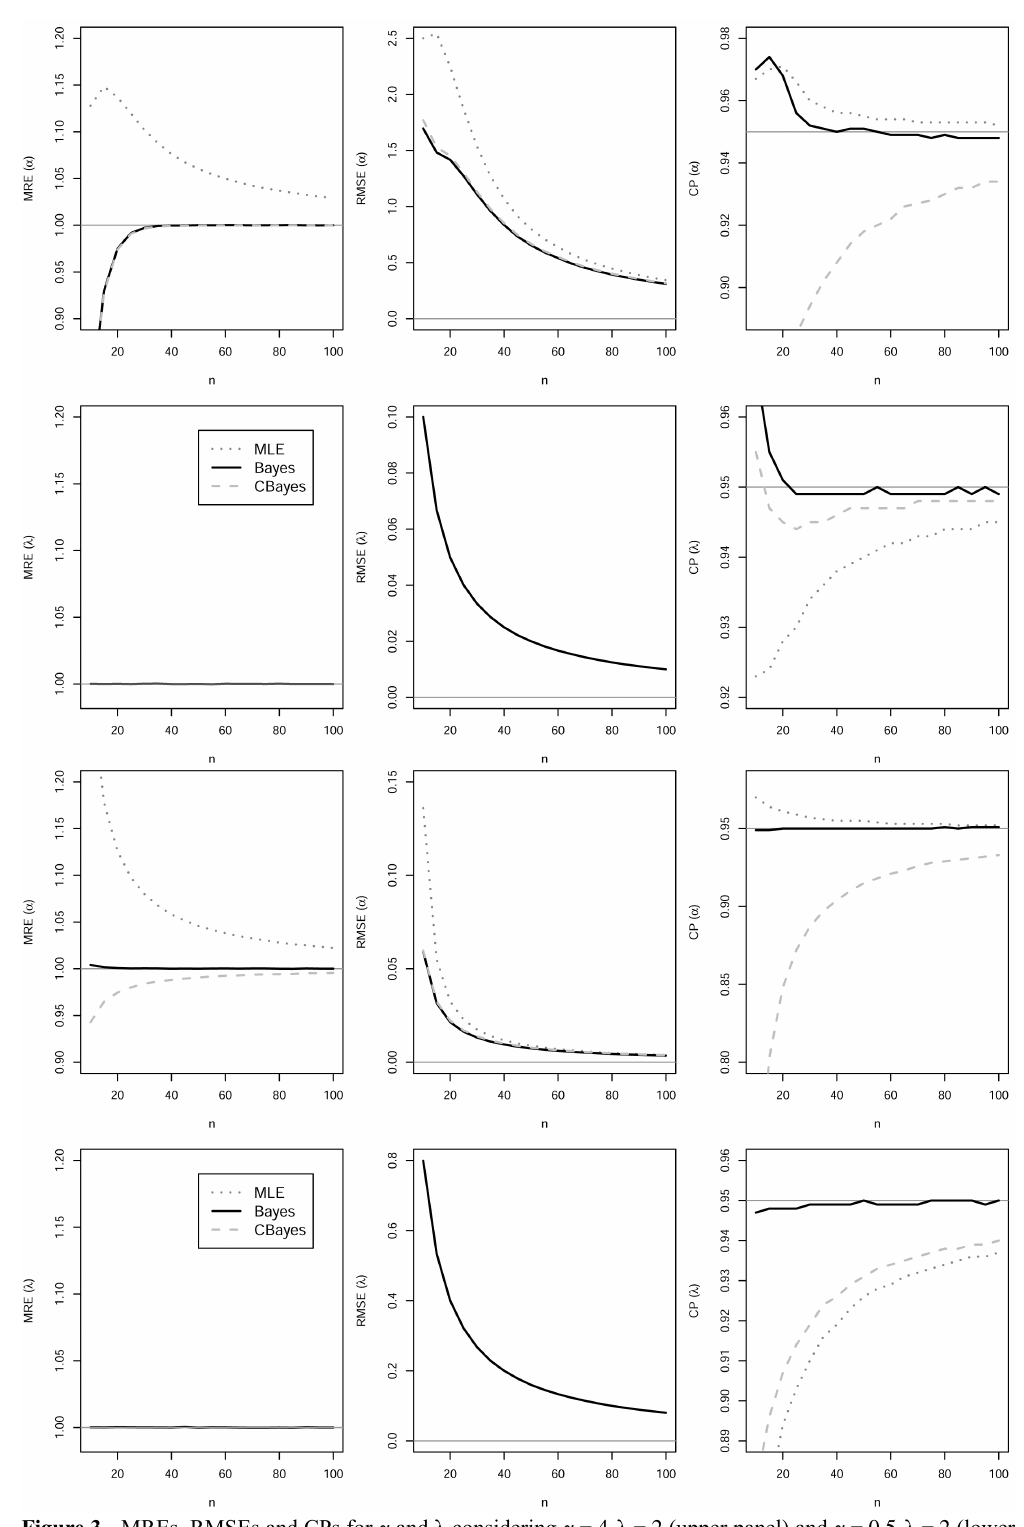
An Acad Bras Cienc (2019)